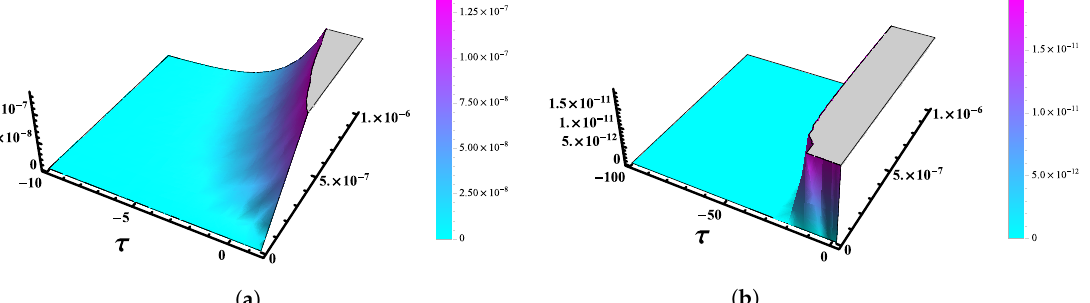
Figure 7. Absolute Error (AE) 3D graph of obtained numerical solutions by using FNAM verses